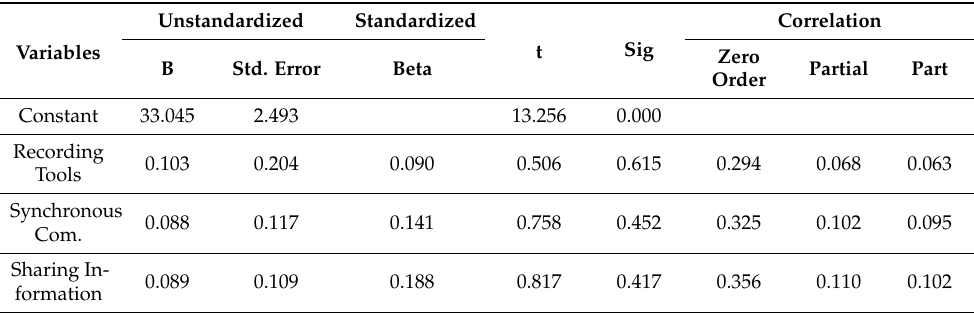
Table 5. Partial analysis of variables of recording tools, synchronous communication, and sharing information on the quality of teacher